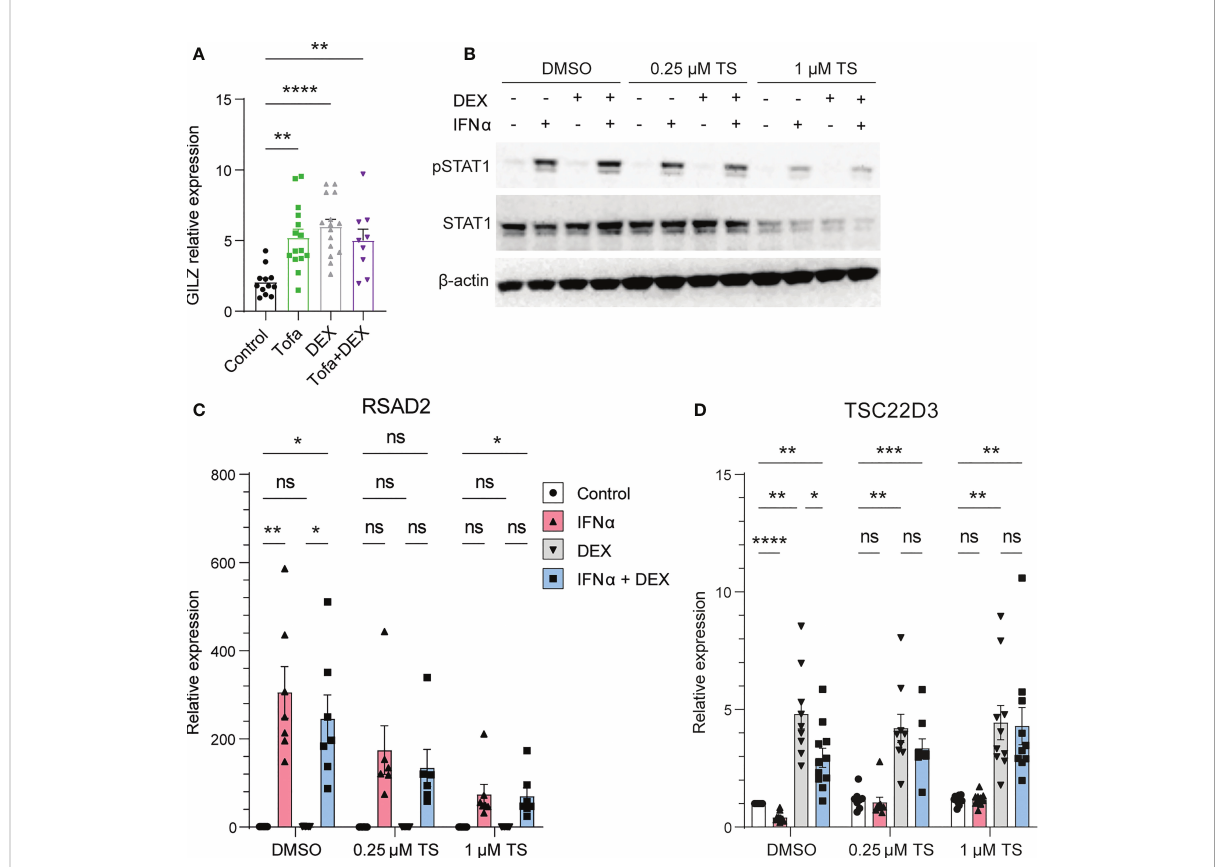
FIGURE 4 JAK1/Tyk2 signaling is involved in IFN-mediated inhibition of GILZ. (A) Kidneys from lupus-prone BWF1 mice treated with tofacitinib, DEX or both were analysed for GILZ expression by qPCR (n=9-15). (B – D) Healthy human PBMC were treated with the Jak1/Tyk2 inhibitor tosylate salt (TS) before exposure to IFN a , DEX or both. Expression of pSTAT1 and STAT1 was analysed by western blot (B) , and RSAD2 (C) and GILZ (D) by qPCR. n=9-11, pooled from three independent experiments. *p<0.05, **p<0.01, ***p<0.001, ****p<0.0001. ns, Not signi fi